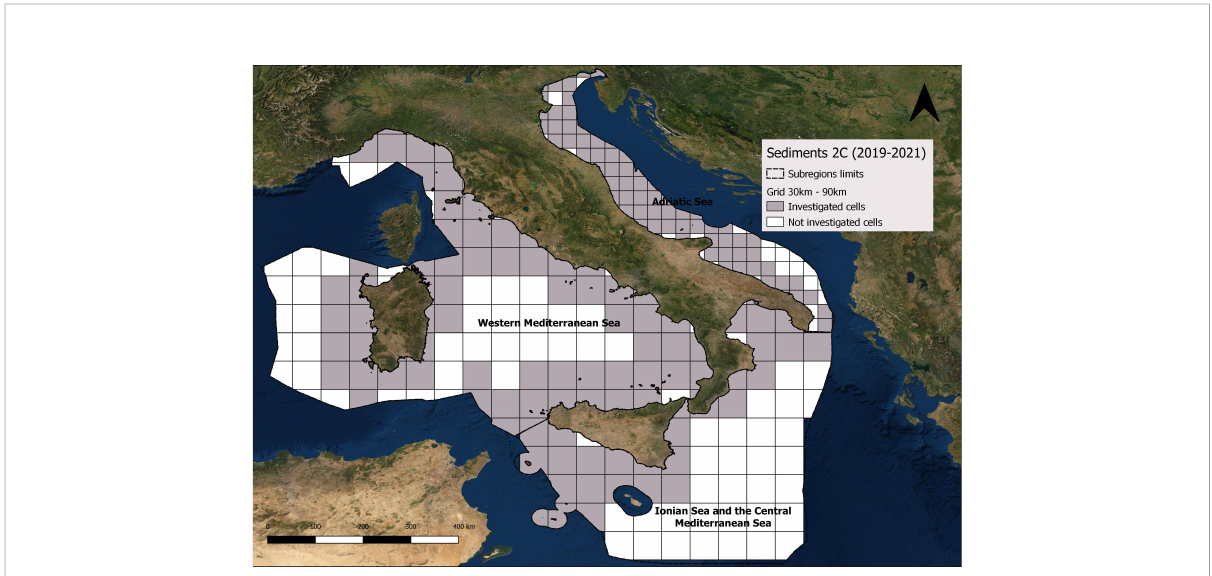
FIGURE 3 Coverage of sediment sampling in all Italian subregions in the second cycle of MSFD (2019 –